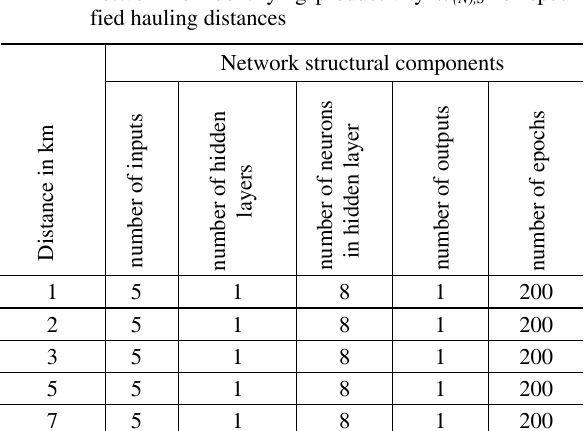
Table 2. Adopted structural components of BPNN-CGB neural network for identifying productivity W (N),S for speci-